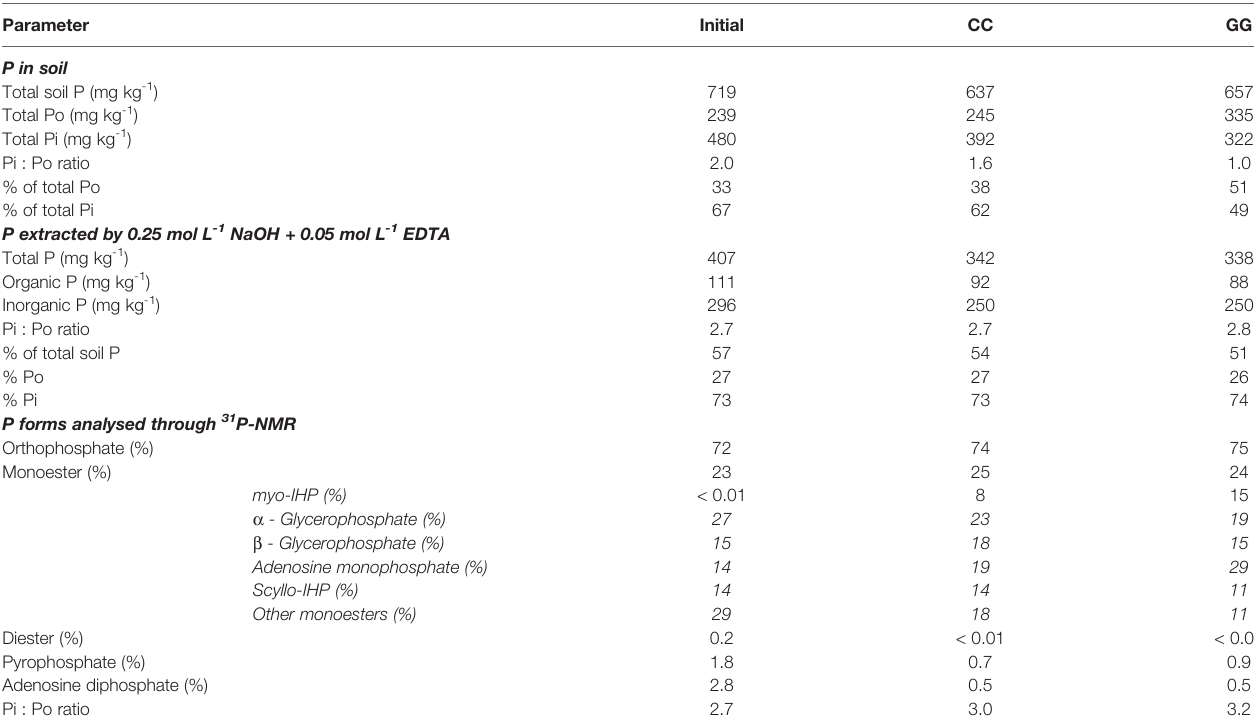
TABLE 1 | Total organic and inorganic P extracted by NaOH + EDTA and P forms analysed through 31 P-NMR in Cambisol managed under permanent cropland (CC) and permanent grassland (GG) for 13 years under a temperate climate. Parameter Initial P in soil Total soil P (mg kg -1